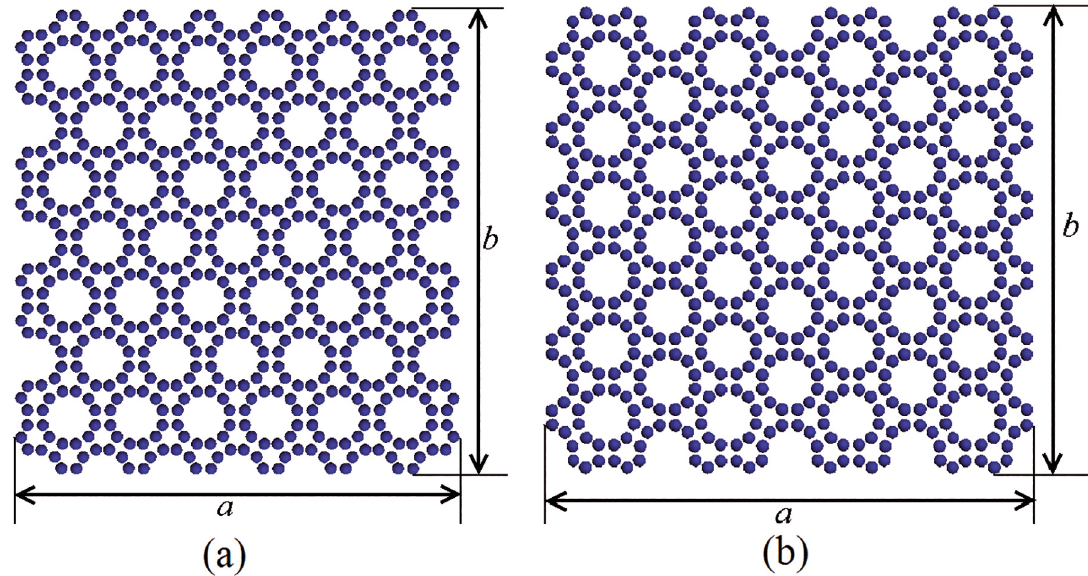
Figure 2: (a) Armchair and (b) zigzag graphenylene with the corresponding geometrical parameters